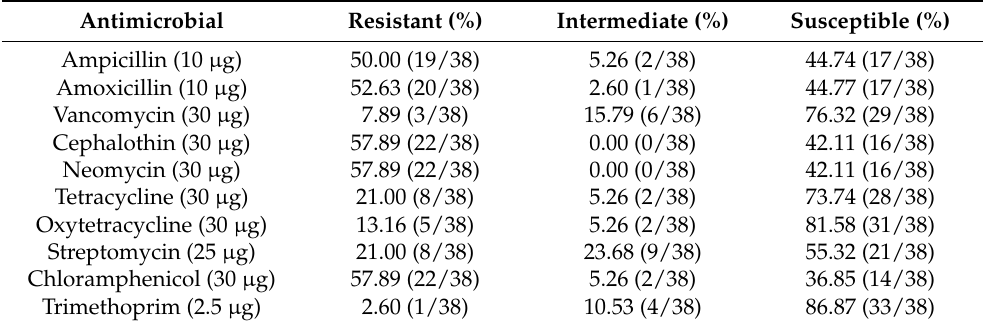
Table 4. Percentage resistance and susceptibility of Chryseobacterium species and Elizabethkingia meningoseptica to antimicrobials.